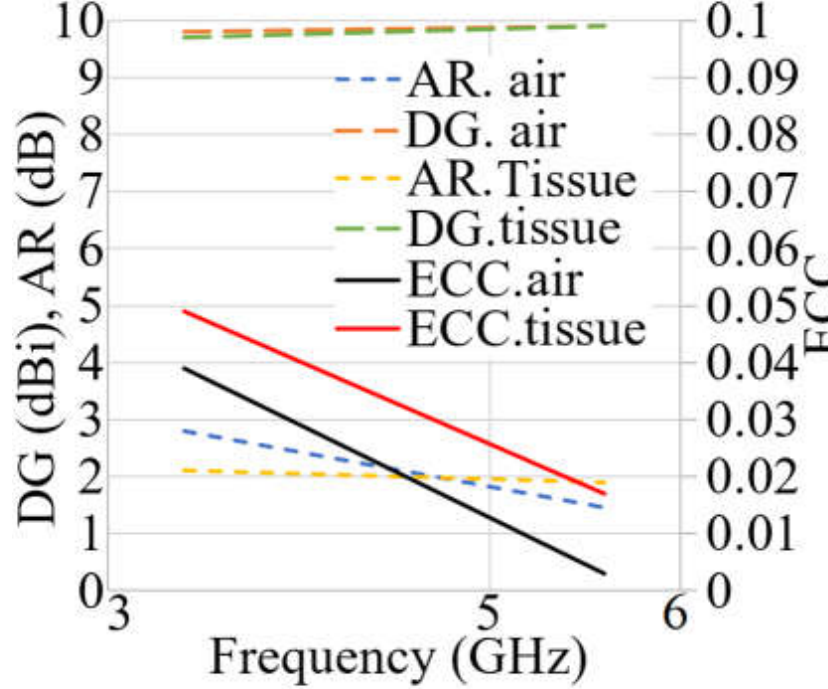
Figure 21. MIMO investigation results of the antenna in terms of DG, AR, and ECC.